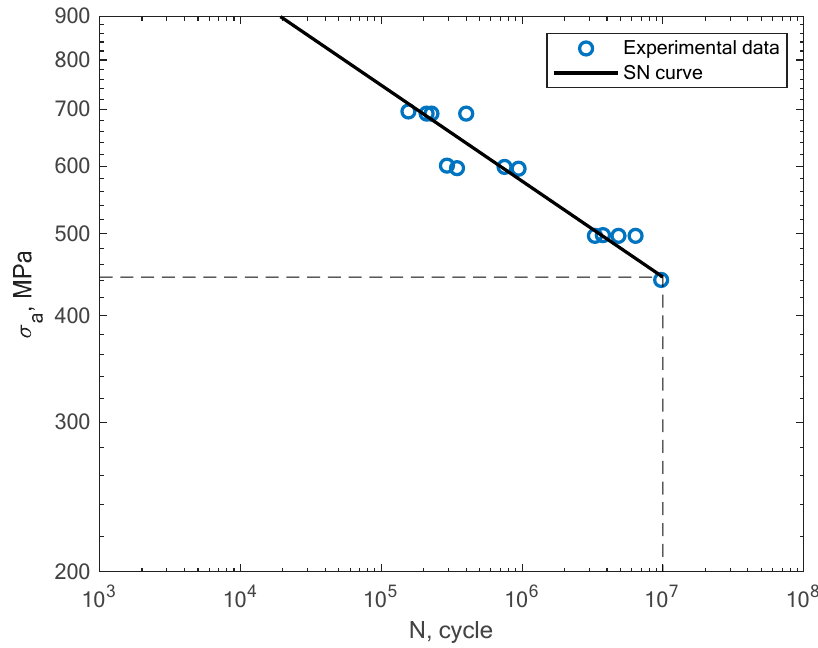
Figure 18. S–N curve for the experimental tension–compression (R = − 1) fatigue test results reported by Damon et al. [17] under the conditions of a high temperature of 400 °C and a vertical direction of the printing orientation.